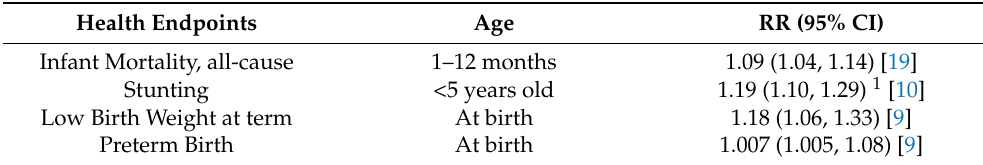
Table 1. Relative risks (RR) and 95% confidence interval (CI) for children and birth outcomes for a 10 µ g/m 3 change in PM 2.5